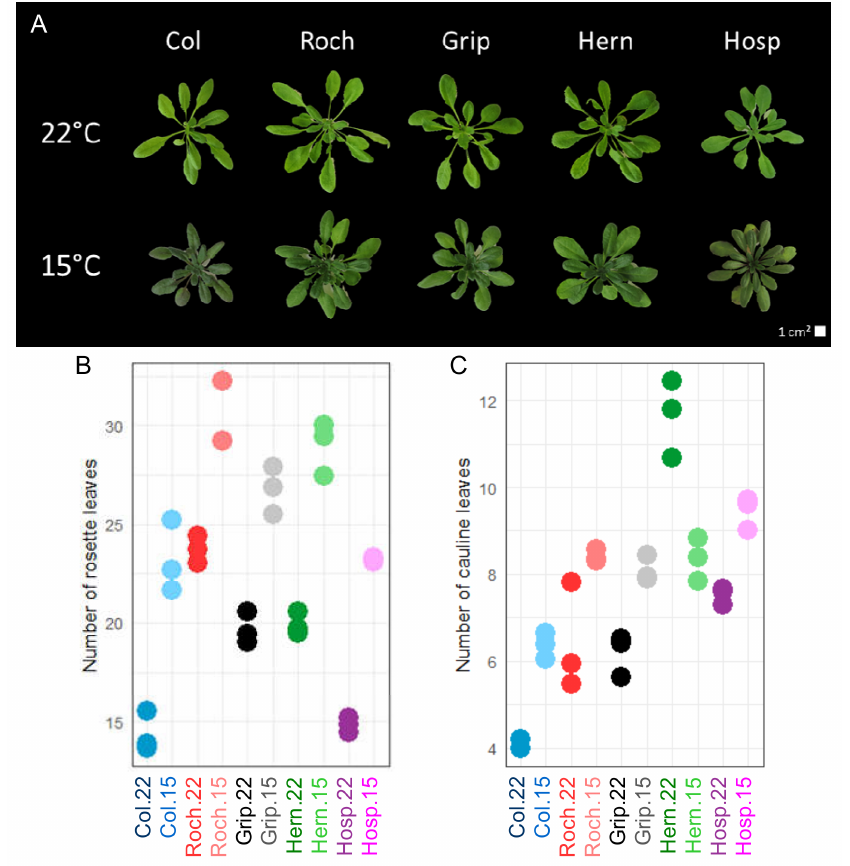
Figure 1. Macro-phenotyping of Col, Roch, Grip, Hern and Hosp grown at 22 or 15 ◦ C. ( A ) Pictures of rosettes at the time of sampling; ( B ) number of rosette leaves at the bolting stage; ( C ) number of cauline leaves at the first flower-stage. Twenty plants from 3 independent batches were analyzed and each dot stands for the mean value for one